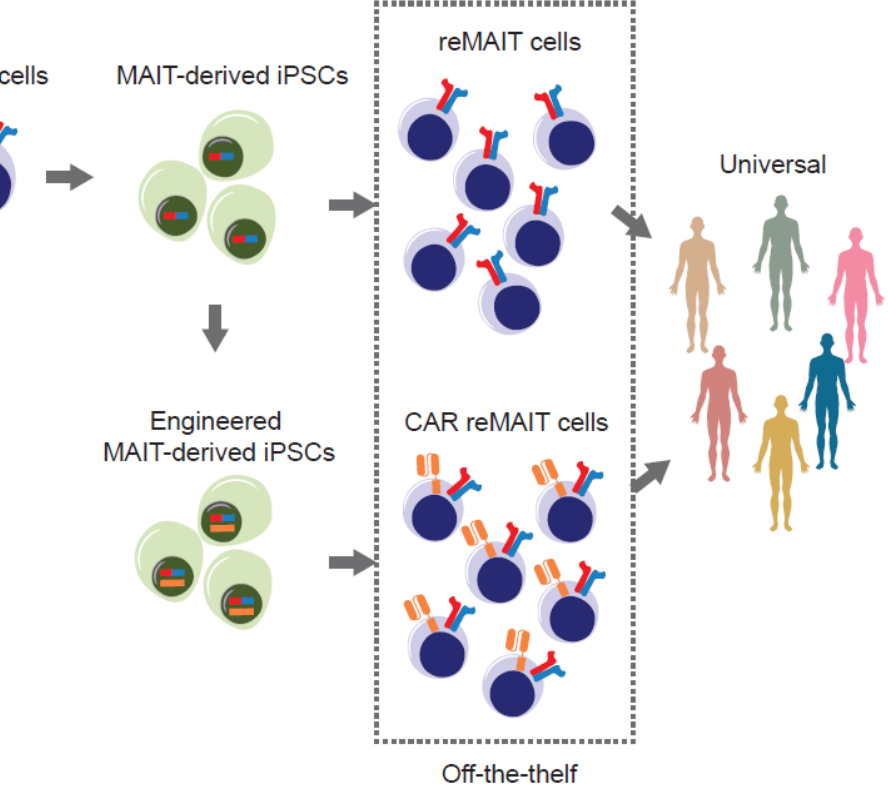
Figure 3. Strategy for harnessing the power of iPSC to develop off-the-shelf tumor immune therapy. MAIT cells from the healthy donor(s) are reprogrammed to iPSCs without genetic modification. MAIT-cell-derived iPSCs (MAIT-derived iPSC) are redifferentiated into MAIT-like cells (reMAIT cells) and used for tumor immune cell therapy. Alternatively, MAIT-cell-derived iPSCs are genetically engineered to express chimeric antigen receptor(s) (CAR) recognizing tumor antigen(s) and redifferentiated into MAIT-like cells expressing CAR (CAR-reMAIT cells) and used for tumor immune cell therapy. In both cases, these cells are suitable for off-the-shelf therapy because MAIT cells from different individuals show an equal reactivity to ligands and are reluctant to be rejected and/or to cause graft-versus-host disease.